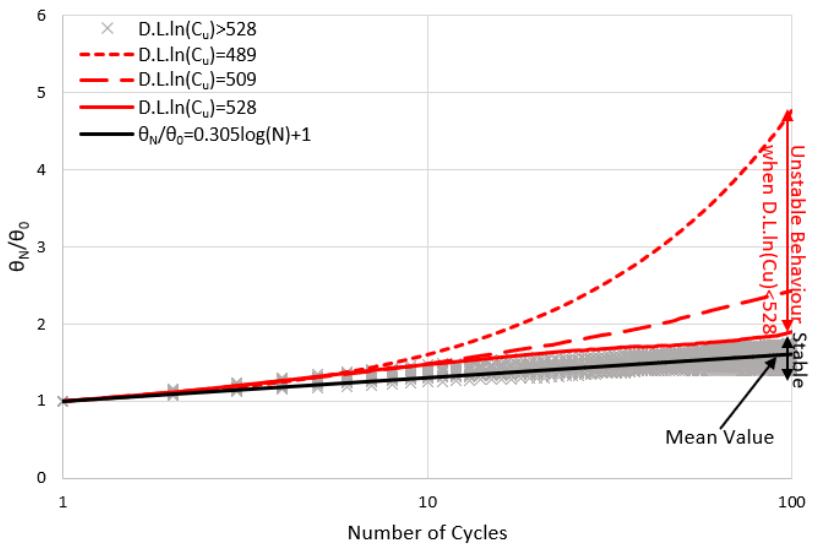
Figure 15. Cumulative rate of rotation for different values of D × L × ln ( C u ) . Using Equation (8), the monopile rotation of a 5 MW wind turbine in any load cycle can be